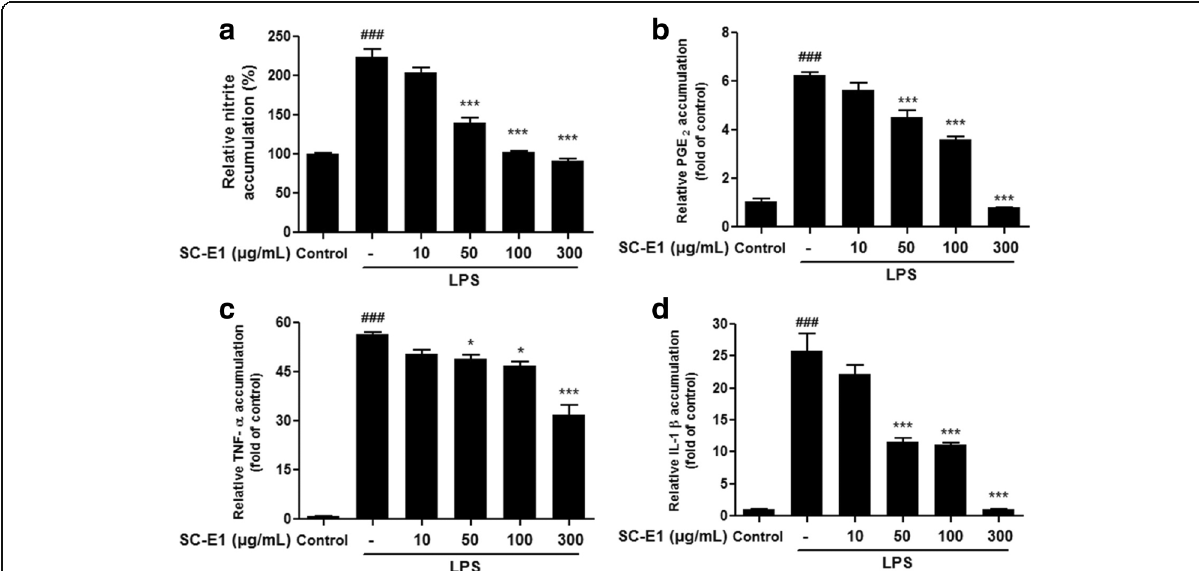
Fig. 3 Effect of SC-E1 on the production of pro-inflammatory mediators and cytokines in LPS-stimulated RAW 264.7 macrophages. a Effect of SC-E1 on nitrite production in LPS-stimulated RAW 264.7 cells. The cells were stimulated with 1 μ g/ml of LPS, in the absence or presence of various concentrations (10, 50, 100, 300 μ g/ml) of SC-E1 for 24 h. Nitrite production by LPS treated macrophages was measured using Griess reagent. Effects of SC-E1 on the secretion of